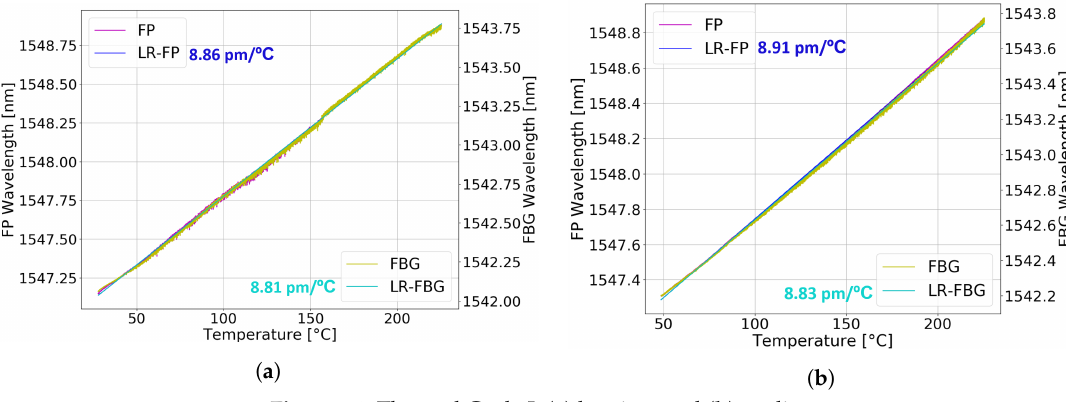
Figure 14. Thermal Cycle I: ( a ) heating; and ( b ) cooling.